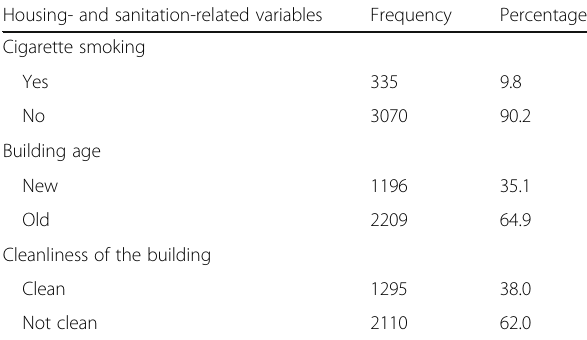
Table 2 Housing condition of study participants in Gondar